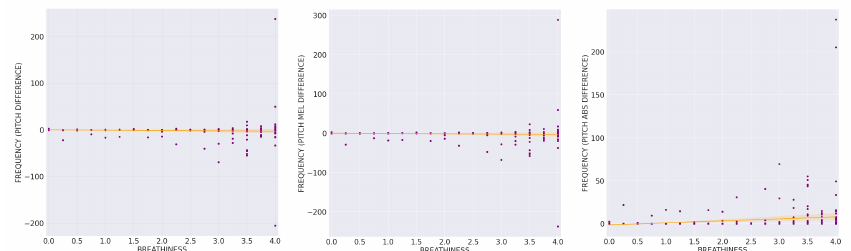
Figure 7. The scatter plots between average breathiness perceptual ratings and the difference of the pitch detection algorithm between the CM and the EGG signals (PD), with r = − 0.0606, p = 0.1966, and ρ = − 0.1436, p = 0.0021, their difference converted in mel scale (MPD) with r = − 0.0494, p = 0.2927, and ρ = − 0.1427, p = 0.0023, and the absolute value of their